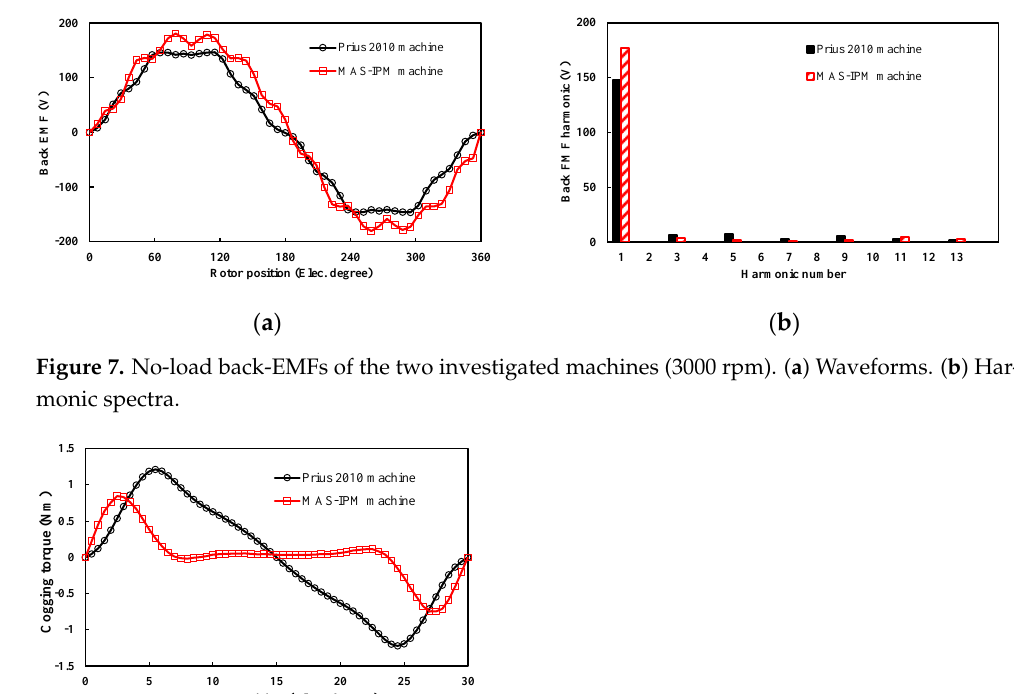
Figure 6. The total torque and torque components versus the asymmetry coefficient α .